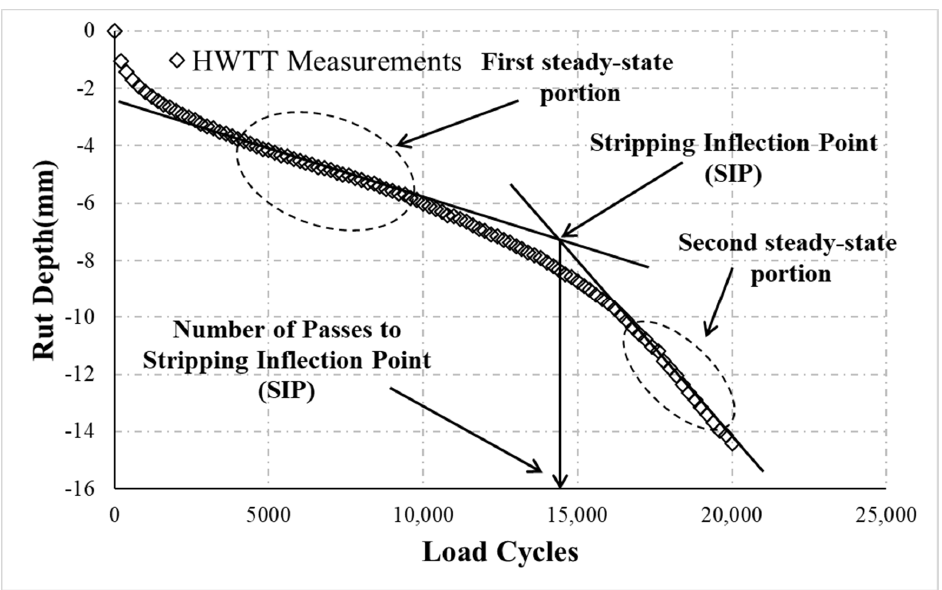
Figure 2. Relationship between the HWTT rut depth and load cycles.